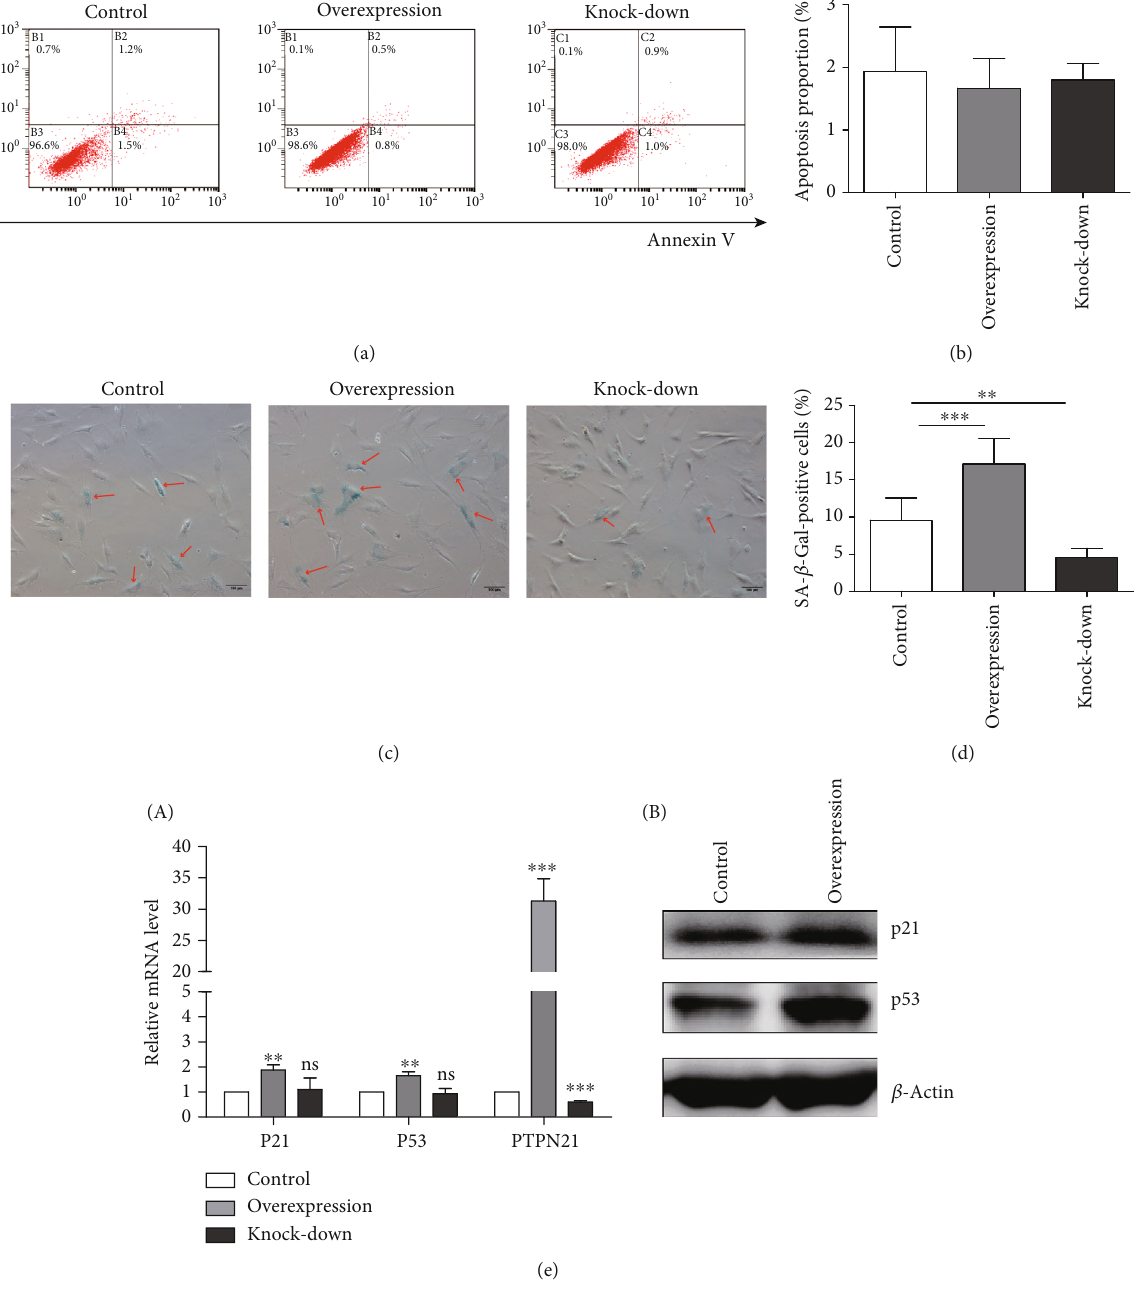
Figure 7: Apoptosis and senescence in BM-MSCs. (a) Flow cytometry analysis of apoptosis in three transfected groups. (b) Statistical analysis of total apoptotic cells in the three groups. (c) SA- β -Gal staining in the di ff erent groups. SA- β -Gal-positive cells are indicated by red arrows. Scale bar = 100 μ m . (d) Statistical analysis of SA- β -Gal-positive cells in the di ff erent groups. (e) mRNA expression (A) and protein expression (B) of p53 , p21 , and PTPN21 in the three groups. All experiments were repeated at least three times. Data are presented as mean ± SD . ∗∗ p < 0 : 01 , ∗∗∗ p < 0 : 001 . ns: no signi fi